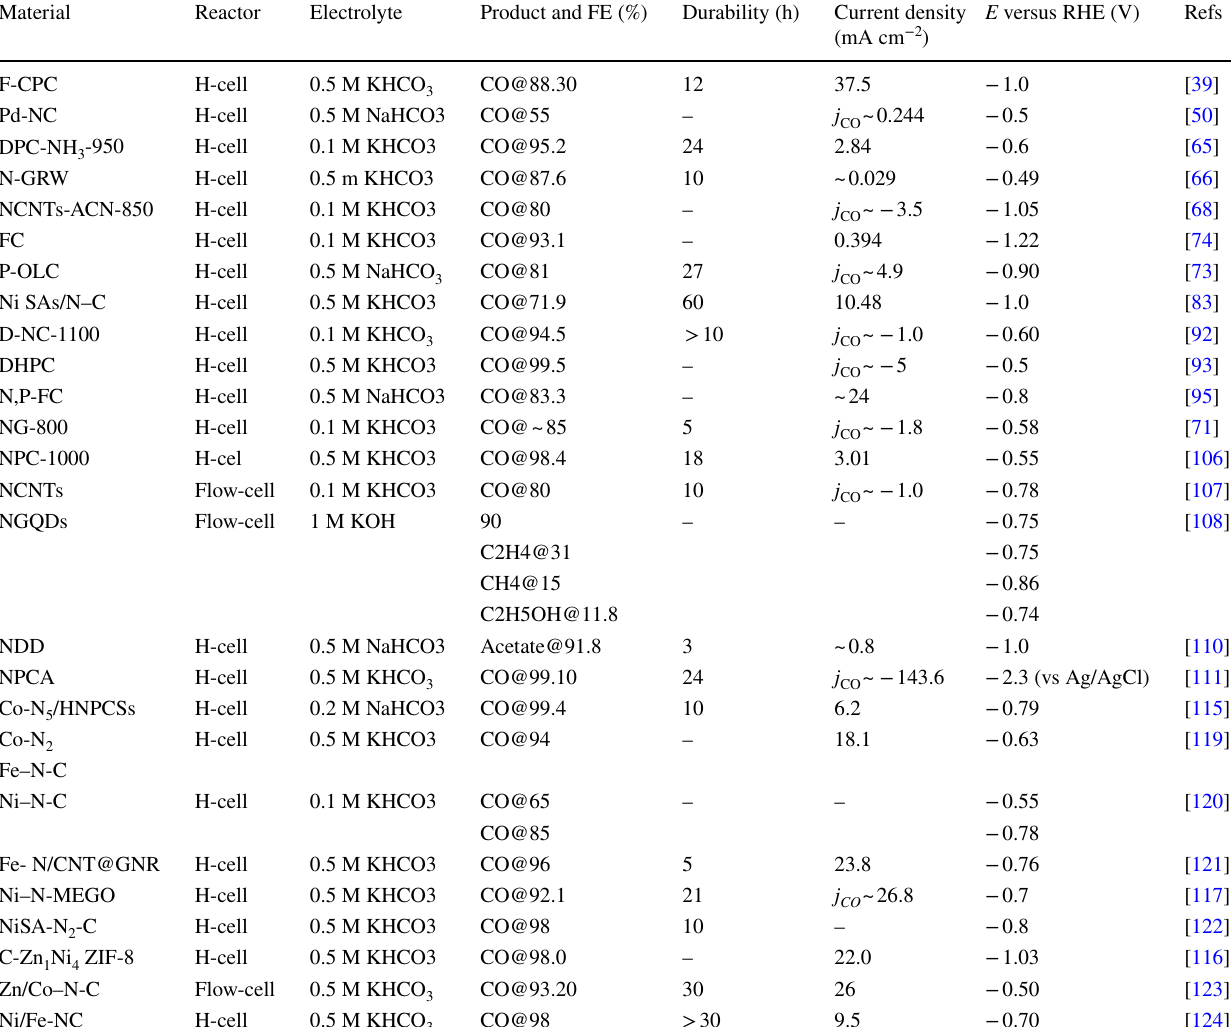
Table 2 Performance comparison of different carbon-based catalysts for ECR